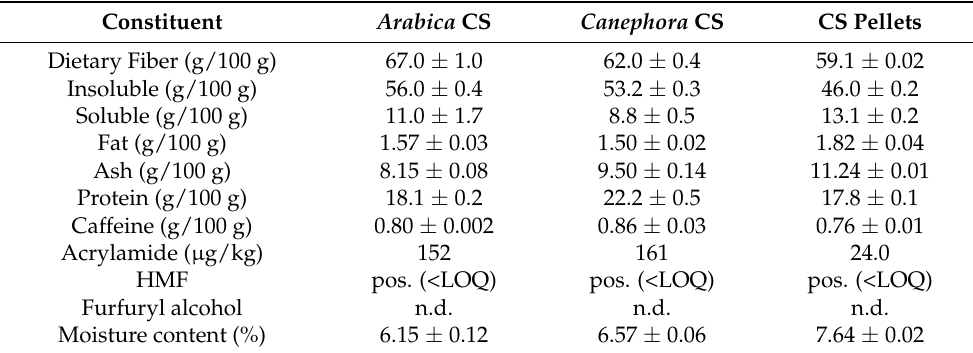
Table 2. Chemical composition of coffee silver skin from Coffea arabica ( arabica CS) and Coffea canephora ( canephora CS) as well as coffee silver skin pellets (CS pellets) based on dry material. Constituent Arabica CS Canephora CS CS Pellets Dietary Fiber (g/100 g) 67.0 ± 1.0 62.0 ± 0.4 59.1 ± 0.02 Insoluble (g/100 g) 56.0 ± 0.4 53.2 ± 0.3 46.0 ± 0.2 Soluble (g/100 g) 11.0 ± 1.7 8.8 ± 0.5 13.1 ± 0.2 Fat (g/100 g) 1.57 ± 0.03 1.50 ± 0.02 1.82 ± 0.04 Ash (g/100 g) 8.15 ± 0.08 9.50 ± 0.14 11.24 ± 0.01 Protein (g/100 g) 18.1 ± 0.2 22.2 ± 0.5 17.8 ± 0.1 Caffeine (g/100 g) 0.80 ± 0.002 0.86 ± 0.03 0.76 ± 0.01 Acrylamide ( µ g/kg) 152 161 24.0 HMF pos. (<LOQ) pos. (<LOQ) pos. (<LOQ) Furfuryl alcohol n.d. n.d. n.d. Moisture content (%) 6.15 ± 0.12 6.57 ± 0.06 7.64 ±